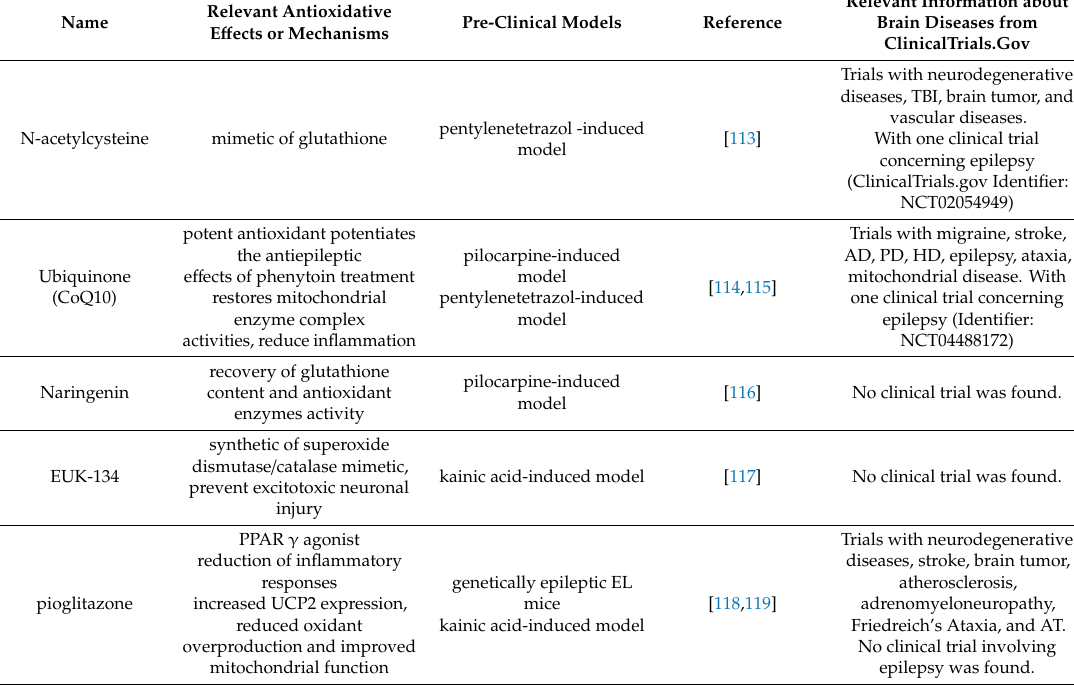
Table 1. Selected references of drugs or chemical compounds with antioxidant characters used in various animal model of status epilepticus. Information concerning clinical trials and various brain diseases including epilepsy and these drugs / chemical compounds from ClinicalTrials.gov are provided. (Abbreviations: Traumatic brain injury, TBI; Alzheimer disease, AD; Parkinson disease, PD; Huntington’s disease HD; Peroxisome proliferator-activated receptor gamma, PPAR γ